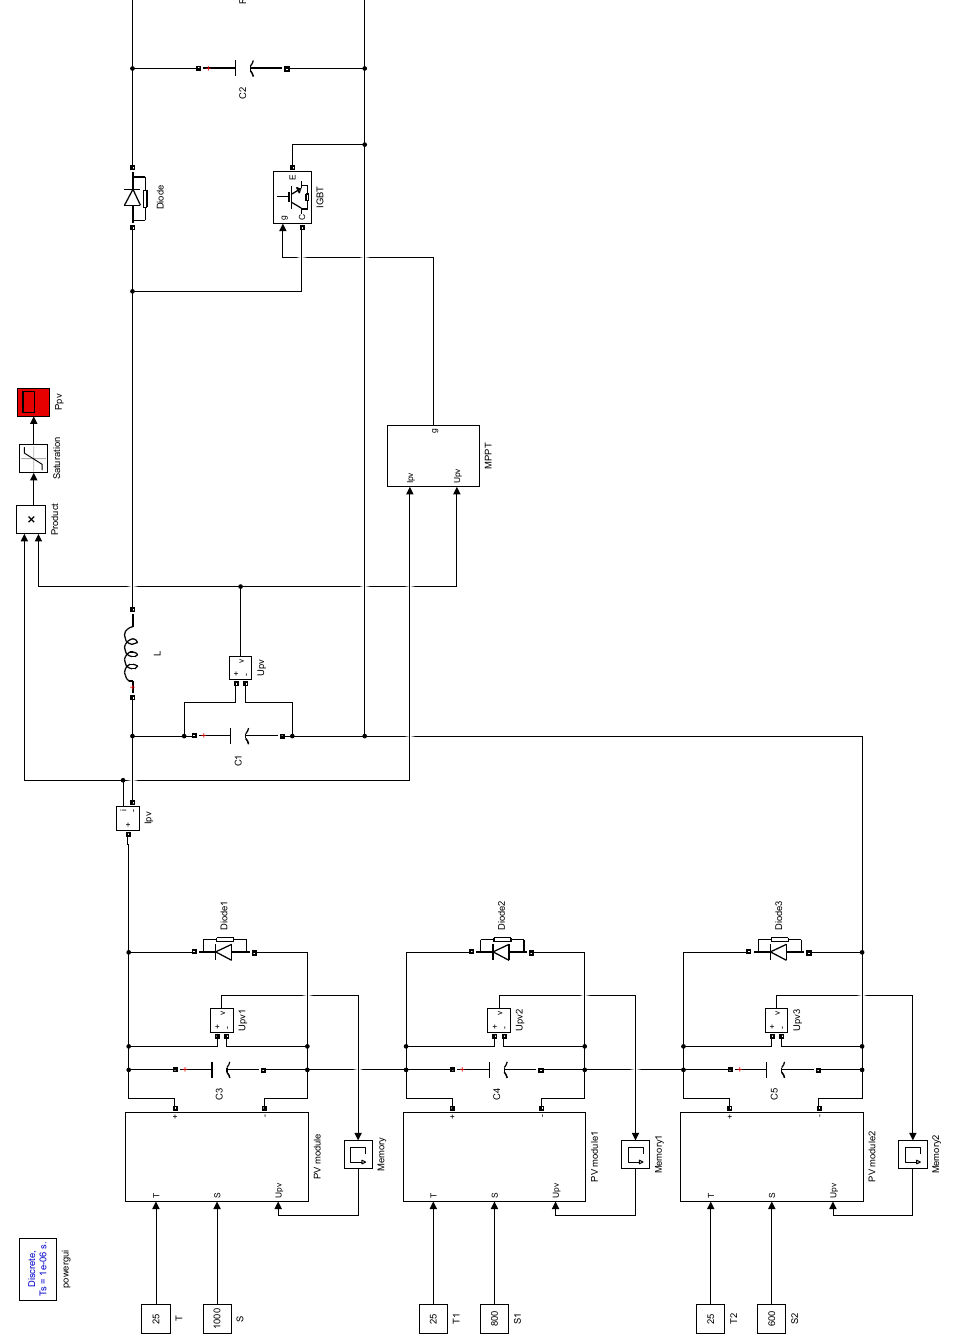
Figure 9. The part of the simulation model of MPPT